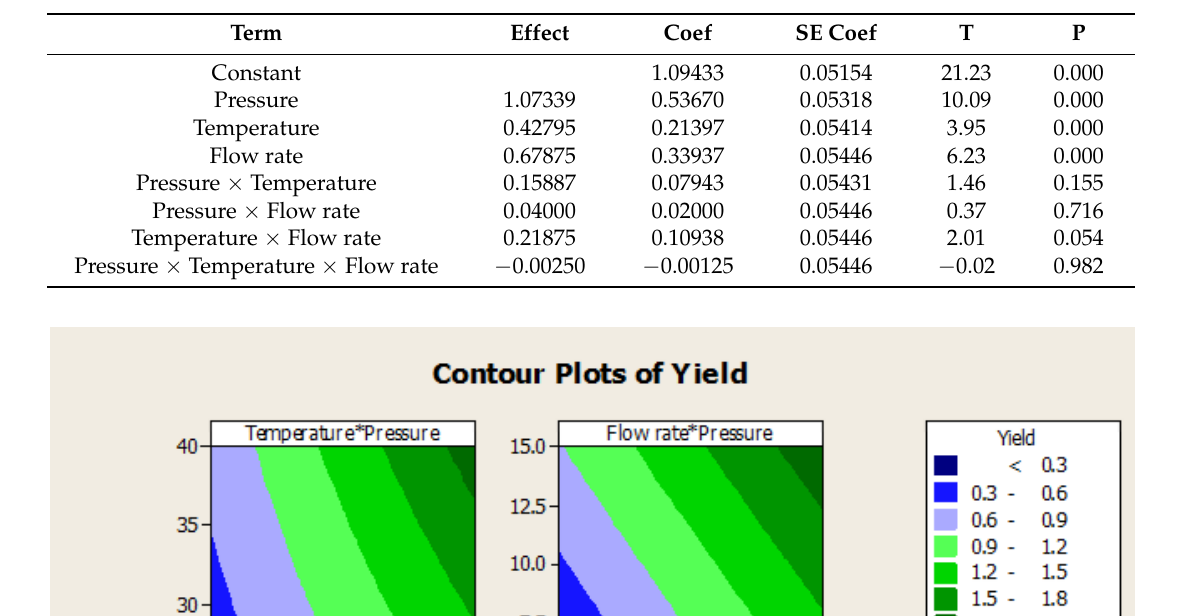
Table 9. Estimated Effects and Coefficients for the Yield.